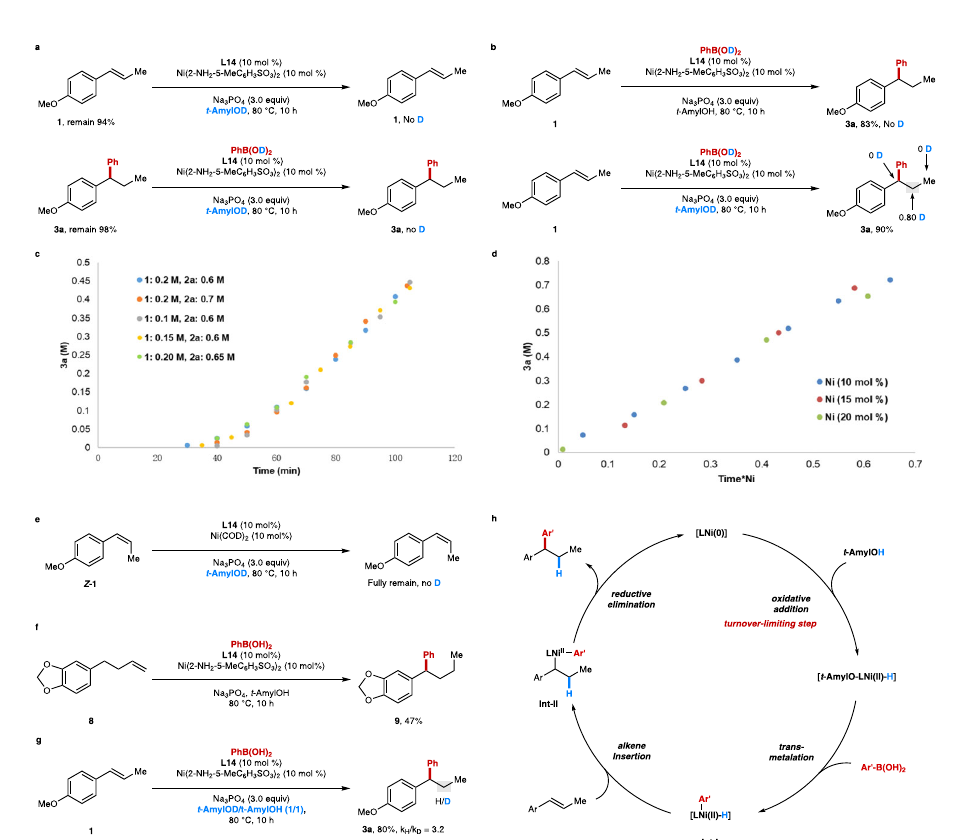
Fig. 6 | Mechanistic studies.a Deuterium scrambling experiments. b Deuteration experiments. c “ Different excess ” experiments for determining the substrates orders. d [Ni] order determination based on the variable time normalization